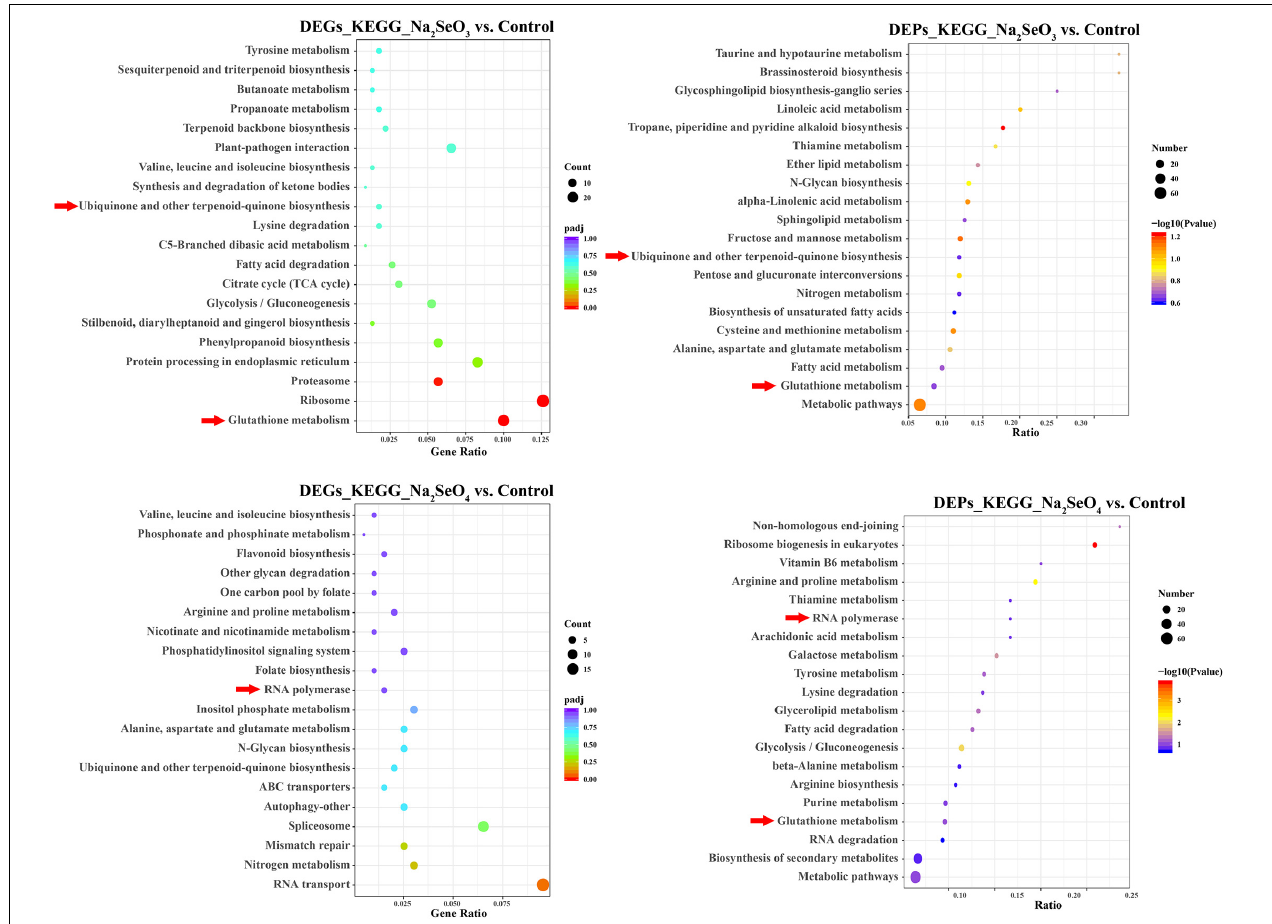
FIGURE 3 | Kyoto Encyclopedia of Genes and Genomes (KEGG) pathway analysis of DEGs and DEPs in response to selenite and selenate treatment,